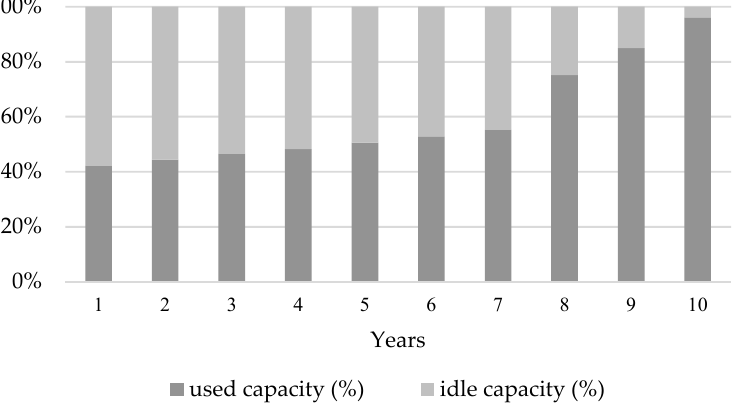
Figure 3. Used vs. idle capacity behavior along the planning horizon. Figure 3. Used vs idle capacity behavior along the planning horizon.